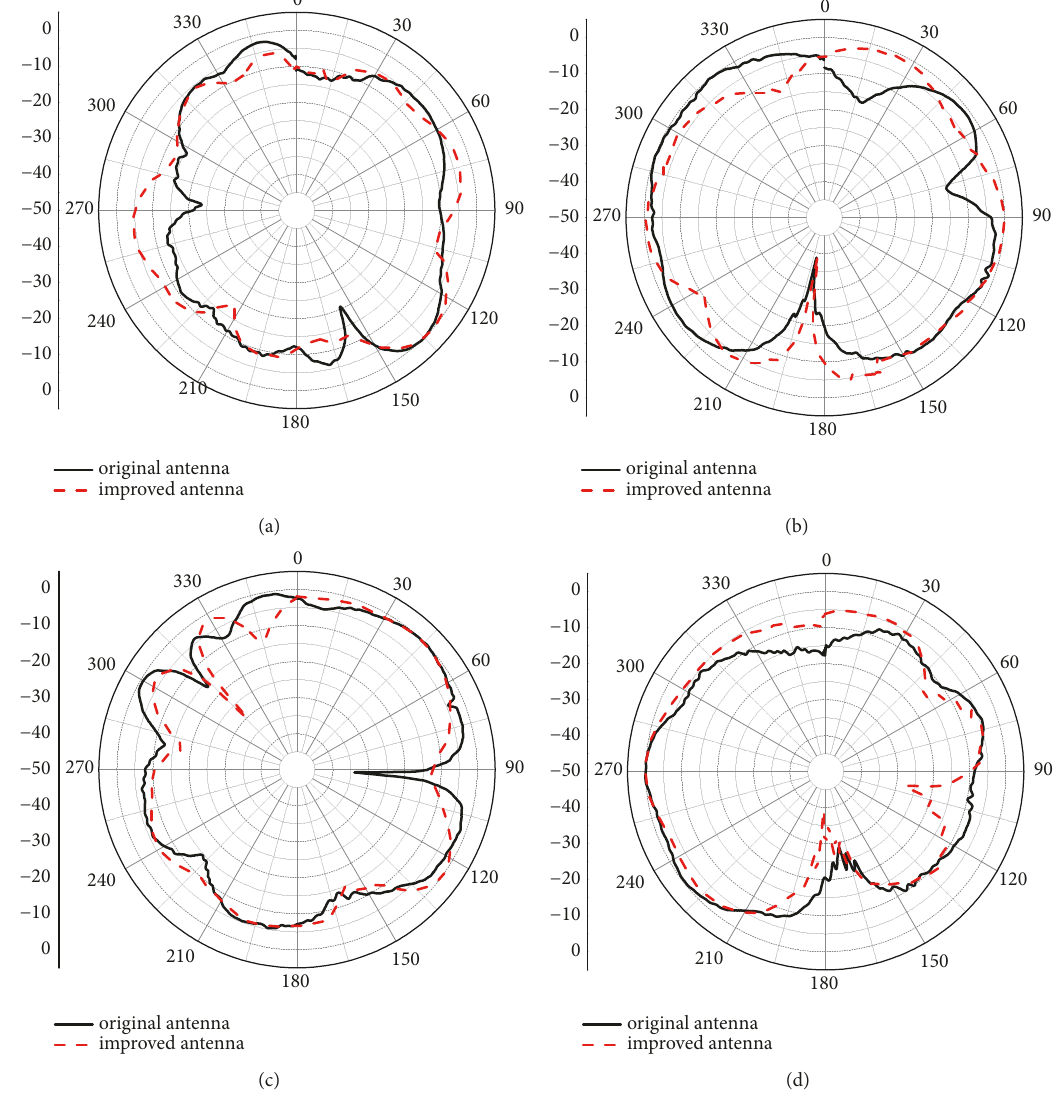
Figure 8: Measured radiation pattern. (a) E plane and (b) H plane at 3.52 GHz; (c) E plane and (d) H plane at 4.9